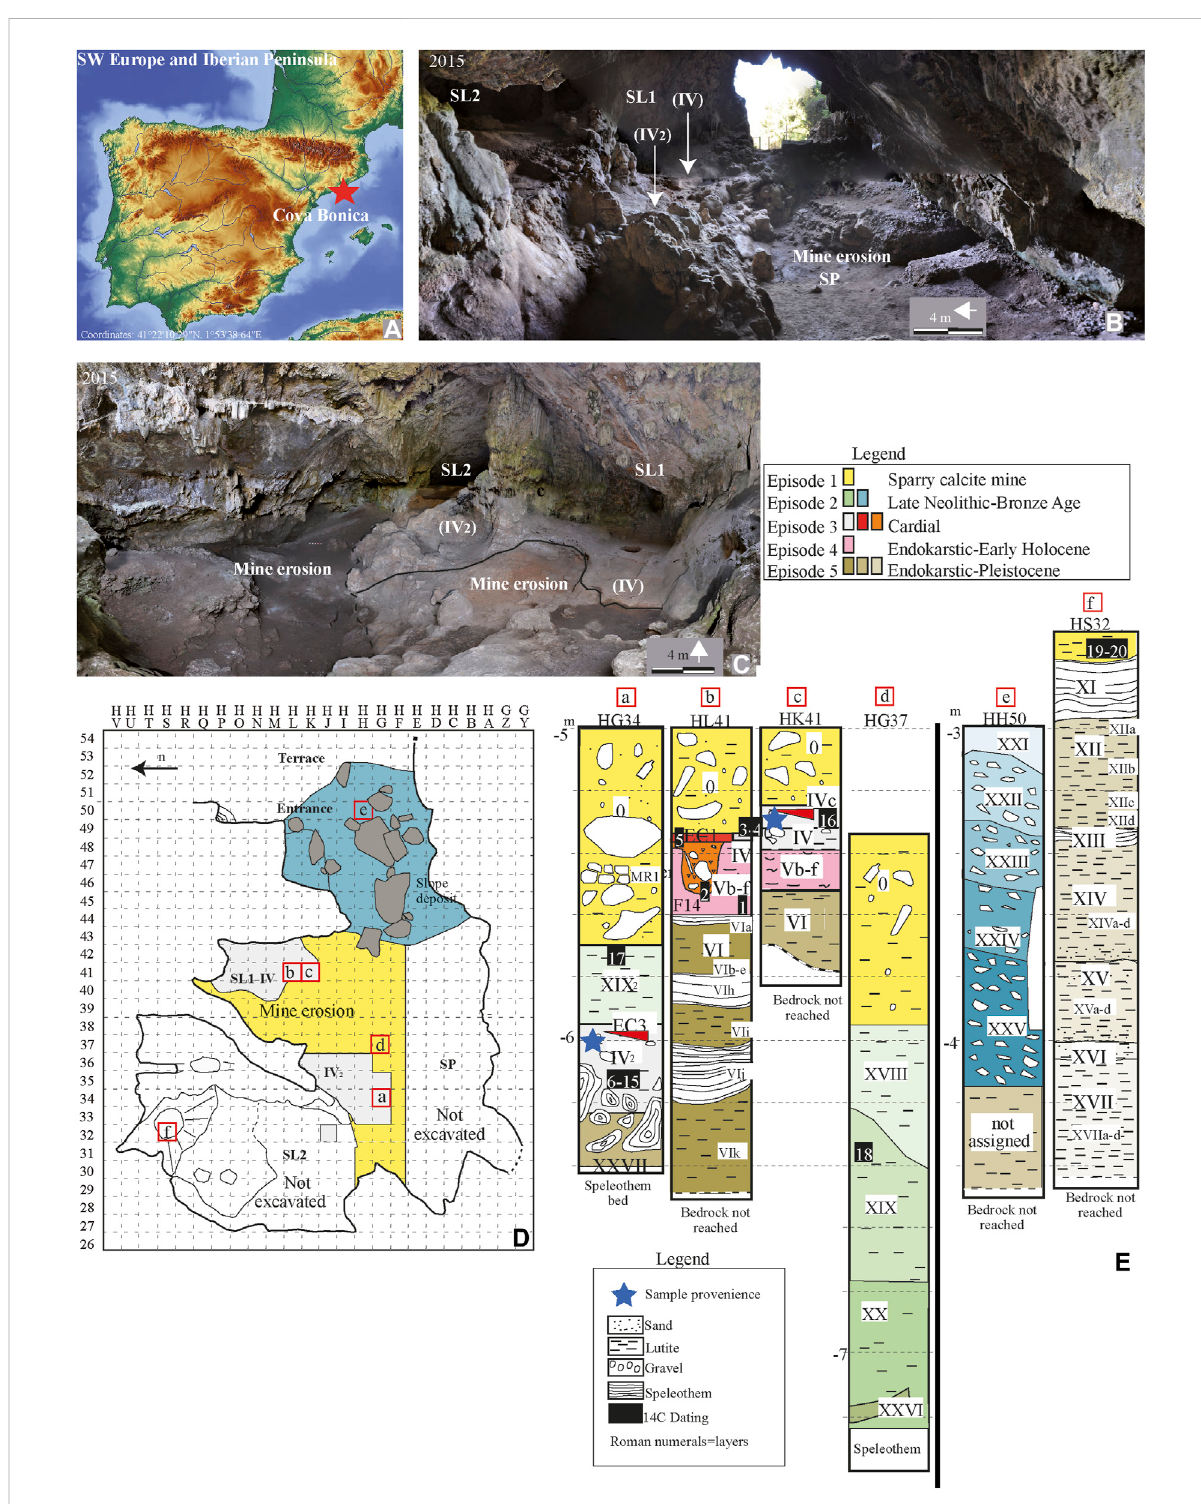
FIGURE 1 Cova Bonica. (A) Location ofCova Bonica intheNE ofthe Iberian Peninsula. (B) Currentview of thecave entrance and mainareas. (C) Neolithic area excavated. (D) Plan of the site indicating the excavated area. (E) Stratigraphy of the site ’ s pro fi les (cave -a to d-, terrace -e-, and SL2